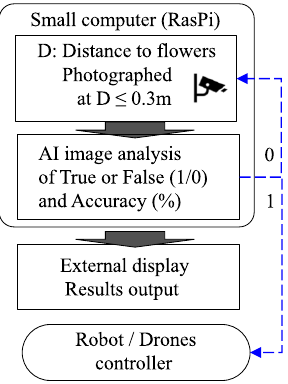
Figure 8. Operation and configuration of the AI image